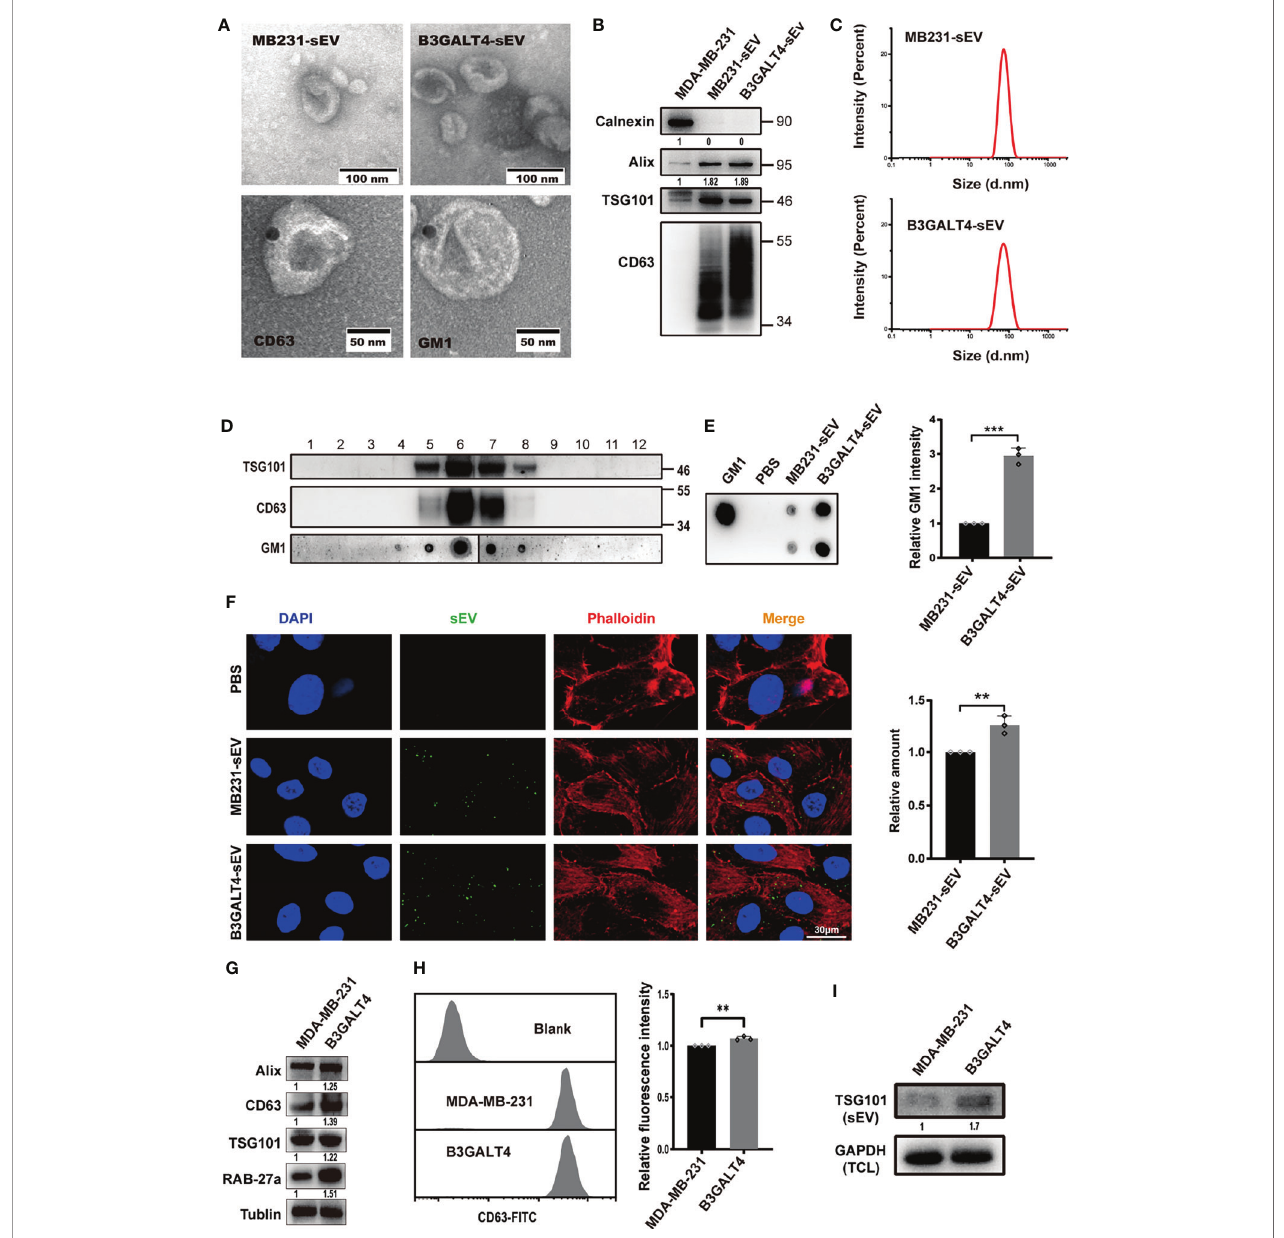
FIGURE 3 | Effects of GM1 on sEV secretion and internalization. (A) Morphology of sEV, Immunogold-labeled CD63 on MB231-sEV and GM1 on B3GALT4-sEV evaluated by TEM. (B) Expression of sEV markers in MB231-sEV and B3GALT4-sEV. (C) Size distribution of MB231-sEV and B3GALT4-sEV evaluated by NTA. (D) The expression of GM1 and sEV markers in density gradient fractionation of MB231-sEV. (E) The expression of GM1 in MB231-sEV and B3GALT4-sEV evaluated by dot blot. (F) Confocal analysis of sEV uptake in MCF-10A. Signals are indicated from a merge image of CFSE-labeled sEV (green), F-actin (red), and nucleus (blue) in MCF-10A treated with MB231-sEV and B3GALT4-sEV. (G) Expression of sEV markers and Rab27a in cell lysates from parental and B3GALT4- transfected MDA-MB-231 cells, evaluated by Western blot. (H) The expression of CD63 on MDA-MB-231 cell surface, evaluated by fl ow cytometry. Blank indicates unstained MDA-MB-231 cells. MDA-MB-231 and B3GALT4 indicate parental and B3GALT4-overexpressed MDA-MB-231 cells stained with antibody against CD63. (I) Expression of sEV marker TSG101 in sEV from equal numbers of B3GALT4-overexpressed and parental MDA-MB-231 cells. ** p < 0.01, *** p < blot ( Figure 3G ) and fl ow cytometry ( Figure 3H ). Since CD63 was ef fi ciently internalized by recipient cells ( Figure S3G ), documented to be associated with sEV secretion (42), these data demonstrating that GM1 could be transferred from donor cells might indicate an enhanced sEV secretion in MDA-MB-231 cells. to recipient cells via sEV. The expression of CD63 was signi fi cantly Meanwhile, sEV was isolated from equal numbers of B3GALT4- increased in B3GALT4-overexpressed cells, examined by Western